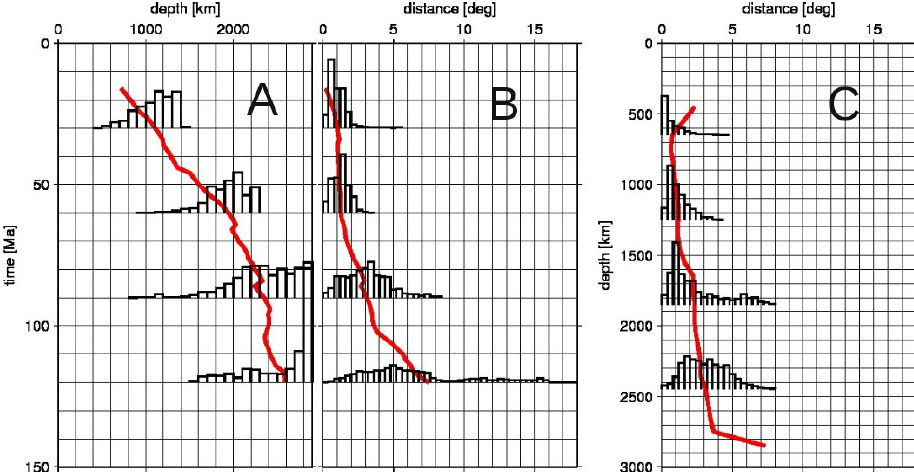
Fig. 4. Left panel (A) : Depth of slab tracers vs. time of subduction. Center panel (B) : Lateral displacement of slab tracers vs. time of subduction. Right panel (C) : Lateral displacement vs. depth. All panels are for model st12den-2; red lines indicate the average, whereas histograms plotted for certain depths or times illustrate variability. Only those slabs subducted since 120Ma are plotted, since older slabs tend to move laterally in the lowermost mantle, and may get heated up and rise again, and would hence make the picture less clear. Both average and histograms consider variable “mass” of slab tracers, which may differ because of variable convergence rate, age of subducted plate and spacing of tracers along subduction zones (which is kept nearly